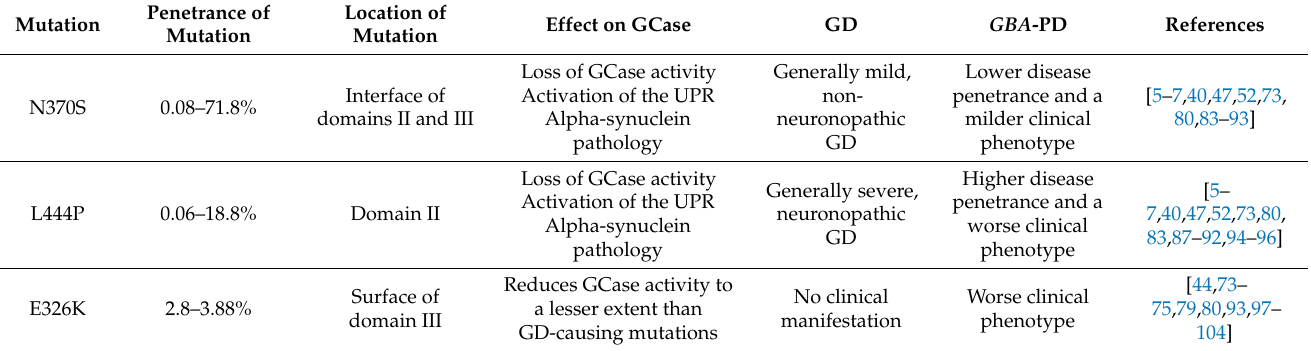
Table 1. Summary of the most common GBA -PD